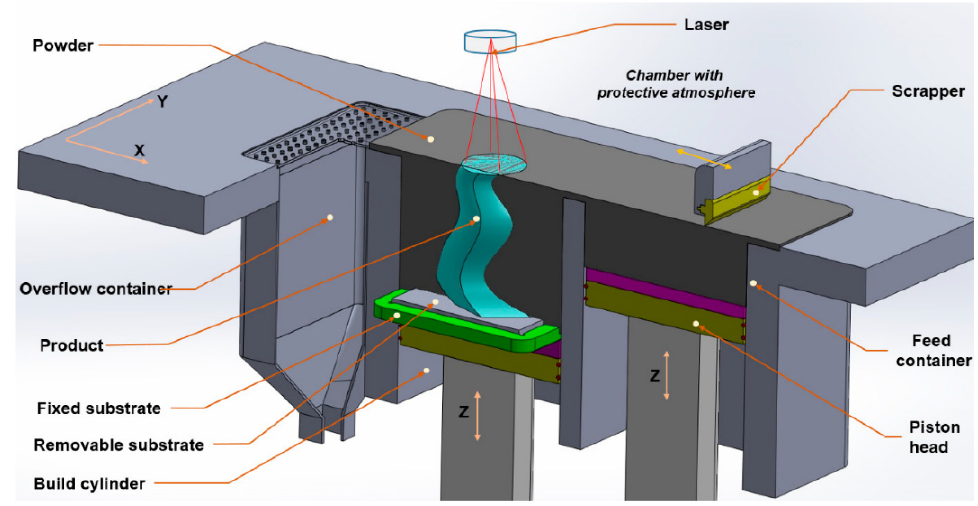
Figure 6. Schematic of the LPBF process. Reproduced from [31], with permission from Elsevier, 2021.